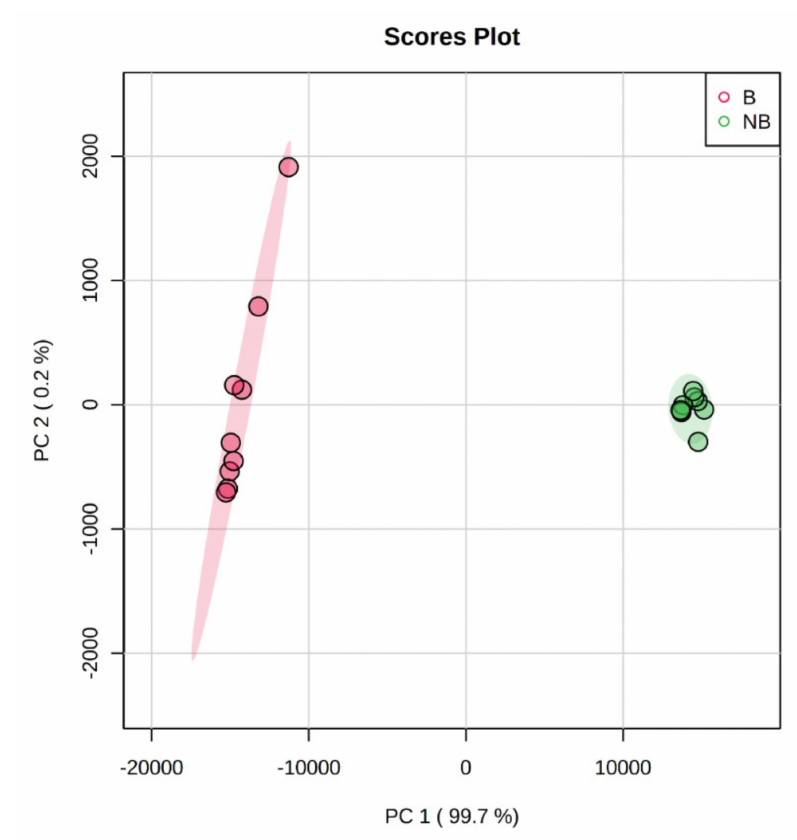
Figure 3. PCA score plot of metabolites detected from scent glands during different reproductive statuses. B, the breeding season; NB, the non − breeding